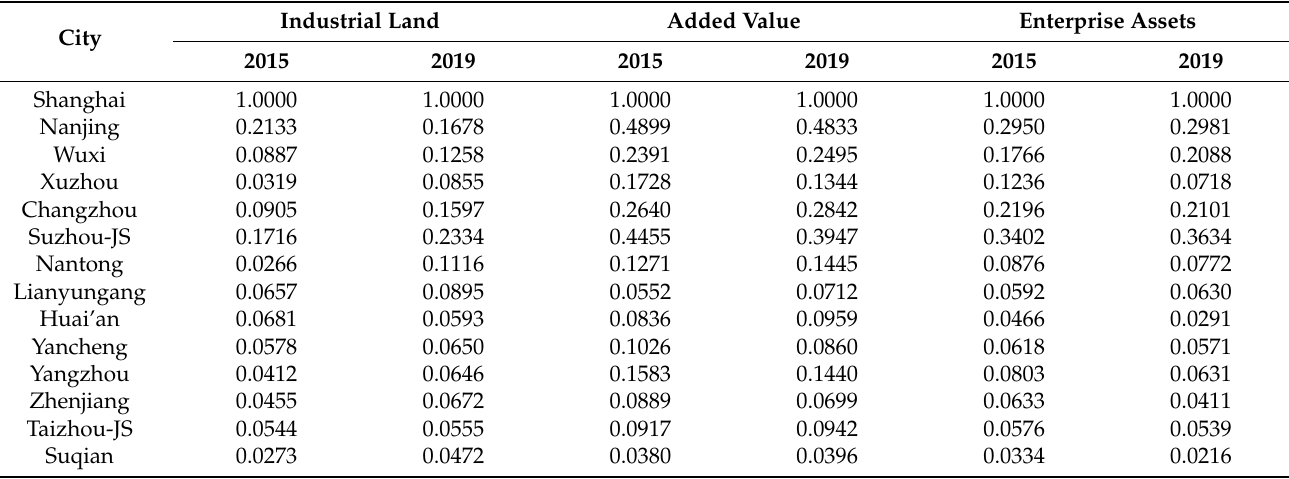
Table A4. Index data based on the max-min standardization method in 2015 and